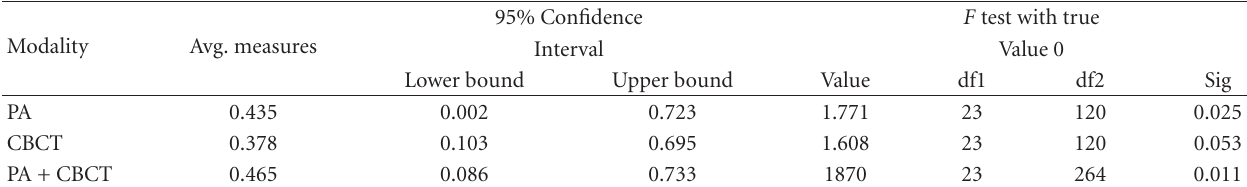
Table 4: Intraclass correlation among observers for PA and CBCT with reference to treatment selection.